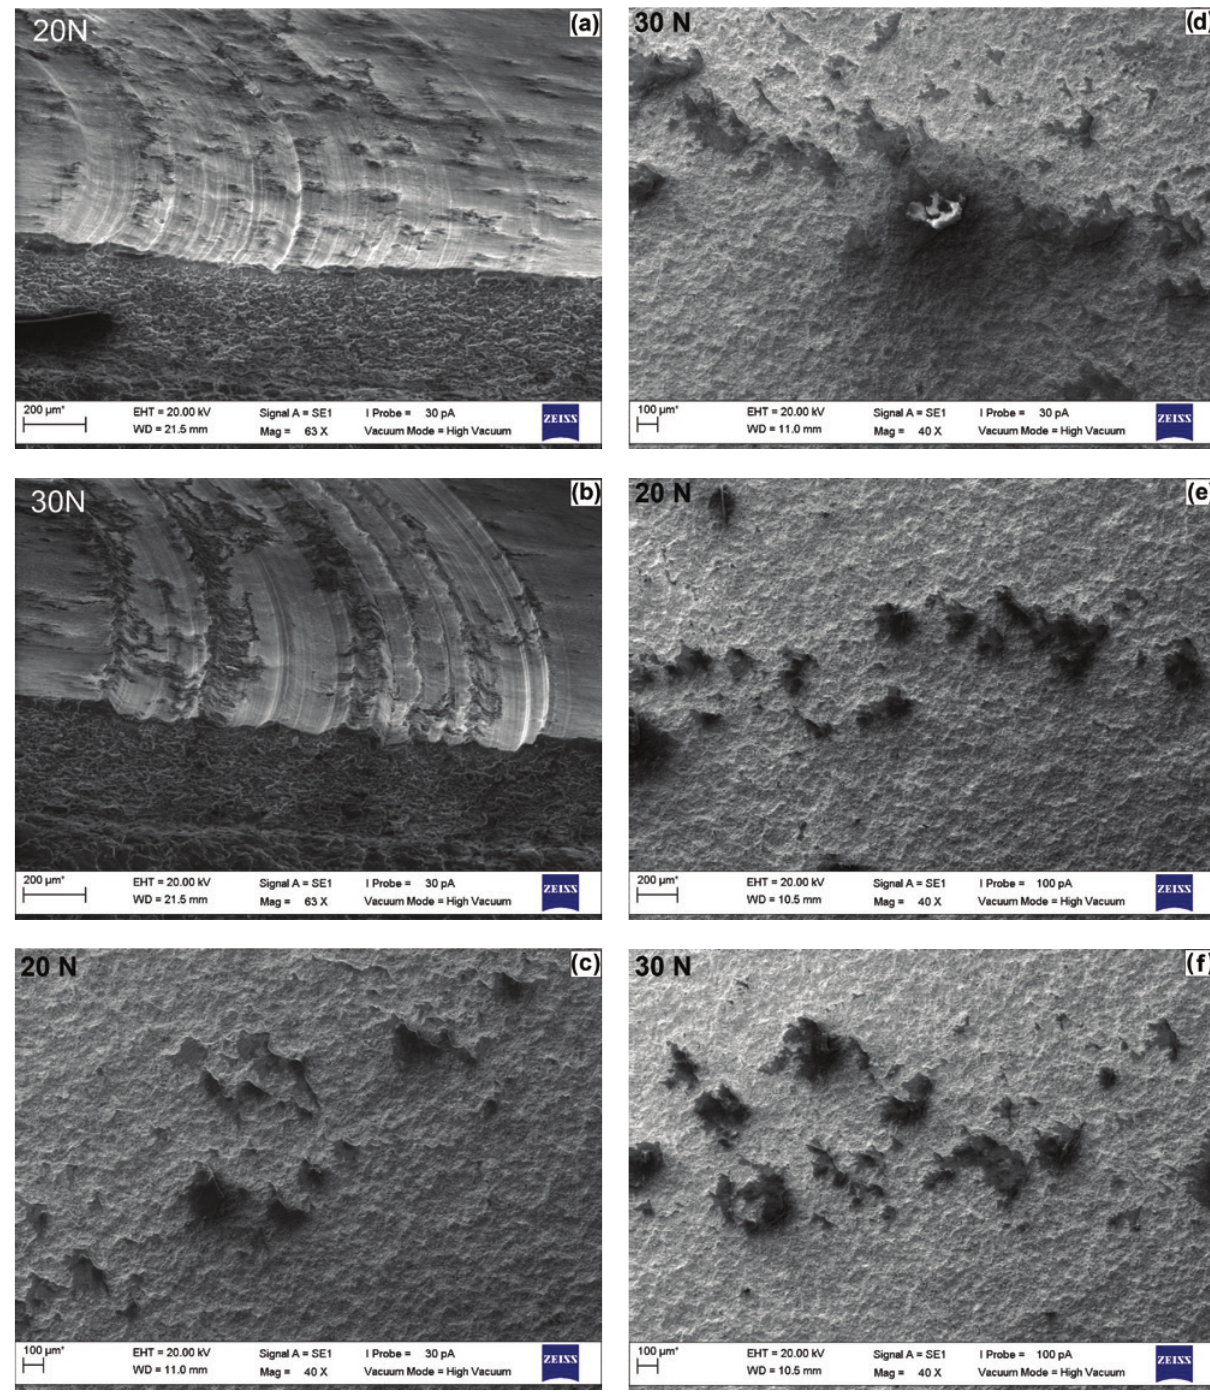
Fig. 5: The cross-sectional SEM images of wear tracks: (a) Uncoated-20N normal load, (b) Uncoated-30N normal load, (c) Coating1-20N normal load, (d) Coating1-30N normal load, (e) Coating2-20N normal load, (f) Coating2-30N normal